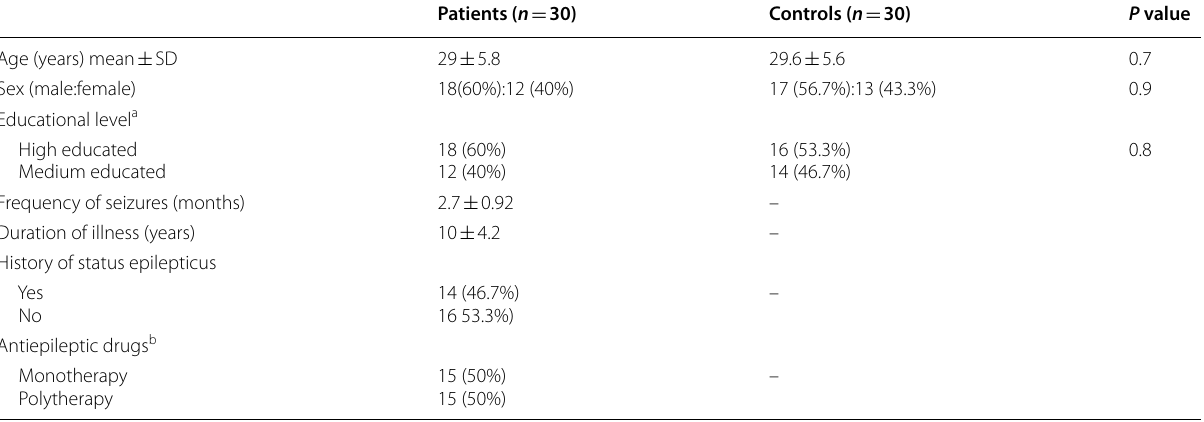
Table 1 Demographic and clinical characteristics of the patients and the control